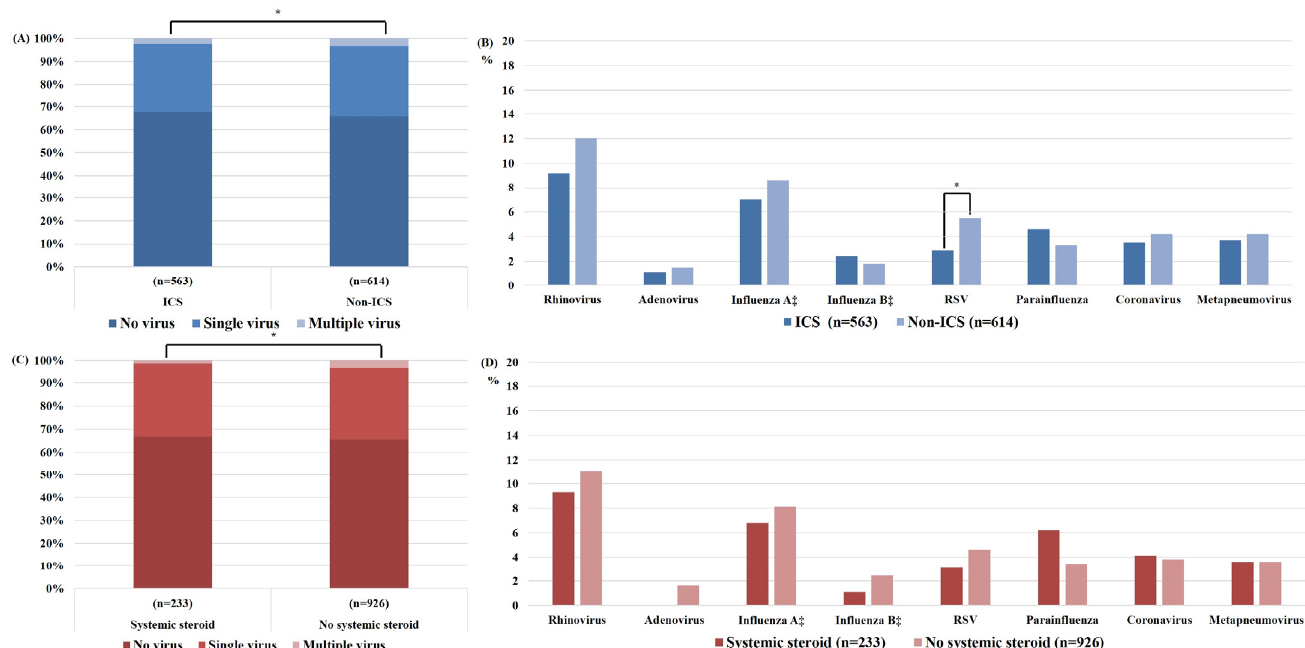
Figure 3. Virus detection rates during acute exacerbations of chronic obstructive pulmonary disease with or without ICS or systemic steroid use: ( A ) overall virus detection rate, ( B ) detection rate for each virus species with or without ICS use, ( C ) overall virus detection rate, and ( D ) detection rate for each virus species with or without systemic steroid use. * p < 0.05, ‡ Viruses were detected in